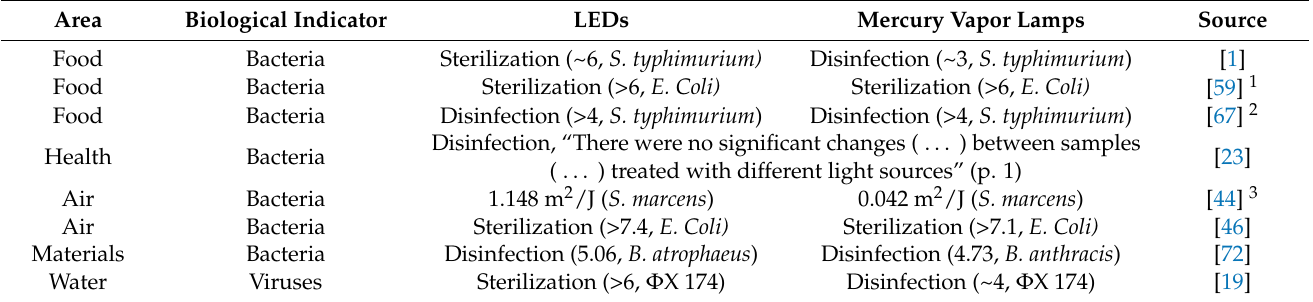
Table 6. A comparison of the decontamination efficacy between UVC LEDs and mercury vapor